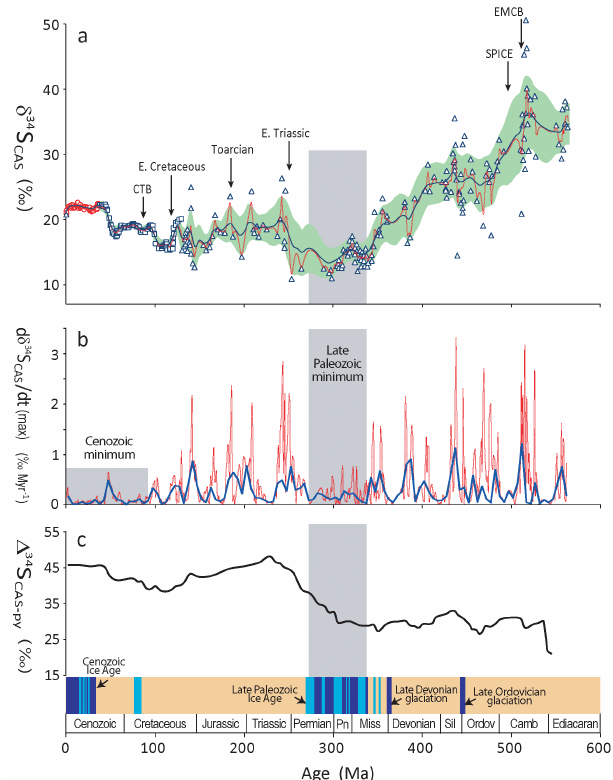
Figure 3. (a) Phanerozoic seawater sulfate δ 34 S. Data sources: Cenozoic (Paytan et al., 1998; red circles), Cretaceous (Paytan et al., 2004; black squares), and pre-Cretaceous (Kampschulte and Strauss, 2004; blue triangles; Table S2). Secular variation in δ 34 S SO4 − SW is shown by a mean LOWESS curve (blue line for low-resolution (5Myr) and red line for high-resolution (1Myr) records) and a standard deviation ( ± 1 σ ) range (green field for low-resolution record; Table S3). Pre-Cretaceous and Cretaceous– Cenozoic estimates of δ 34 S SO4 − SW have uncertainties of ± 2– 7‰ and ± < 1‰, respectively. The labels represent four short- term ( < 2Myr) intervals of high-frequency ∂δ 34 S SO4 /∂t variation (EMCB: early–middle Cambrian boundary; SPICE: Steptoean posi- tive carbon isotope excursion; CTB: Cenomanian–Turonian bound- ary). (b) Rate of seawater δ 34 S variation ( ∂δ 34 S SO4 /∂t ) as cal- culated from the seawater sulfate δ 34 S LOWESS curves. The maxi- mum Phanerozoic ∂δ 34 S SO4 /∂t is < 4‰Myr − 1 , although rates of 10 to > 50‰Myr − 1 have been reported from some high-resolution CAS studies. (c) (cid:49) 34 S CAS-PY for Phanerozoic marine sediments (data from Fig. 3 of Wu et al., 2010). The continental glaciation record is adapted from Montañez et al. (2011); all ages were con- verted to the Gradstein et al. (2012)